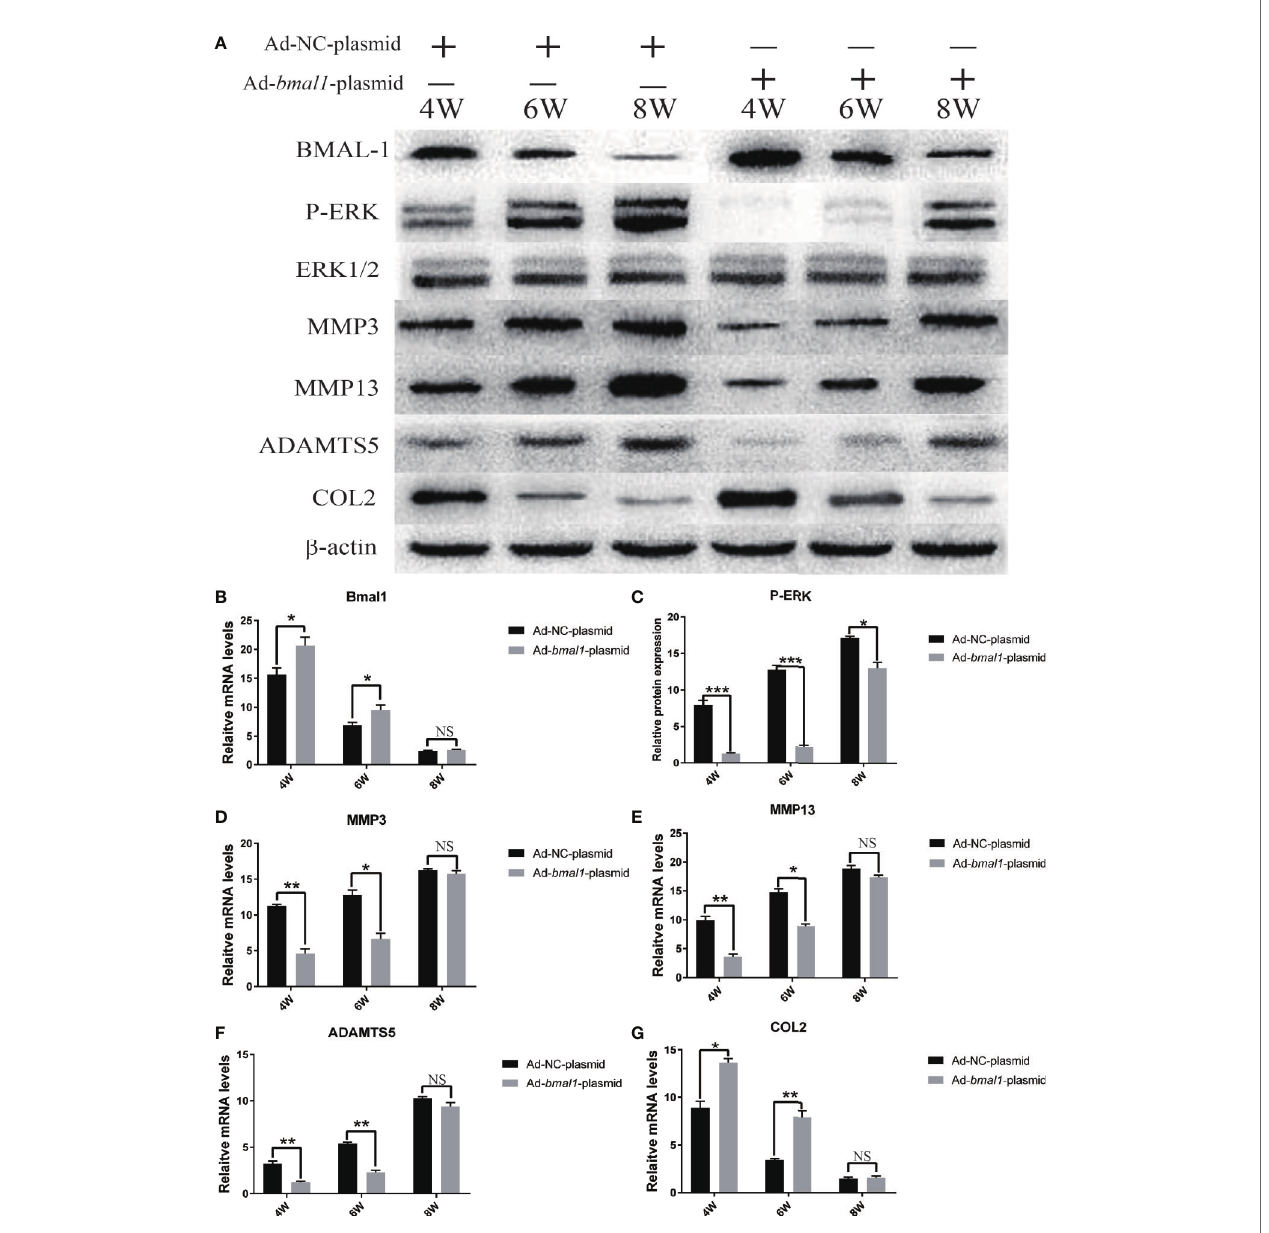
FIGURE 7 | BMAL-1 overexpression reverses TMJ-OA in rats. Ad-NC plasmid and Ad-bmal1 plasmid were injected IA into the TMJs of mice once per week for 4, 6, and 8 weeks. (A) Compared with that in rats transfected with Ad-NC-plasmid, the P-ERK, MMP3/13 and ADAMTS5 upregulation was signi fi cantly delayed in bmal1 overexpression rats. (B) qRT-PCR results indicated decreased bmal1 mRNA levels in vivo after Ad- bmal1 plasmid transfection. (C) Western blotting assay images show that CRD-induced P-ERK upregulation in cartilage was markedly abrogated in bmal1 overexpression rats. (D) The CRD-induced MMP3 mRNA upregulation in cartilage was markedly abrogated in bmal1 overexpression rats. (E) The CRD-induced MMP13 mRNA upregulation in cartilage was markedly abrogated in bmal1 overexpression rats. (F) The CRD-induced ADAMTS5 mRNA upregulation in cartilage was markedly abrogated in bmal1 overexpression rats. (G) The CRD-induced COL2 mRNA downregulation in cartilage was markedly abrogated in bmal1 overexpression rats. All experiments were performed in triplicate, and the results are expressed as the mean ± SD. *P < 0.05; **P < 0.01, ***P < 0.005. NS, not signi fi